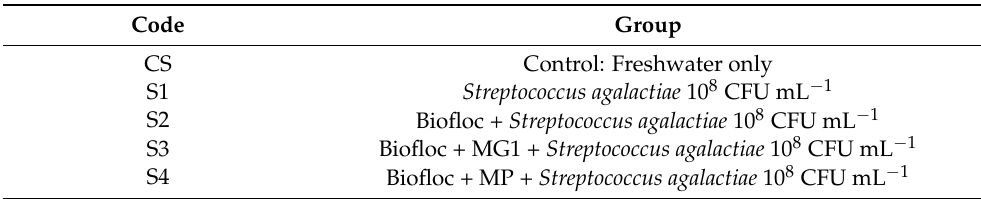
Table 2. Test groups of tilapia cultured in freshwater and biofloc group against pathogenic Streptococ- cus agalactiae in in vivo challenge assay.